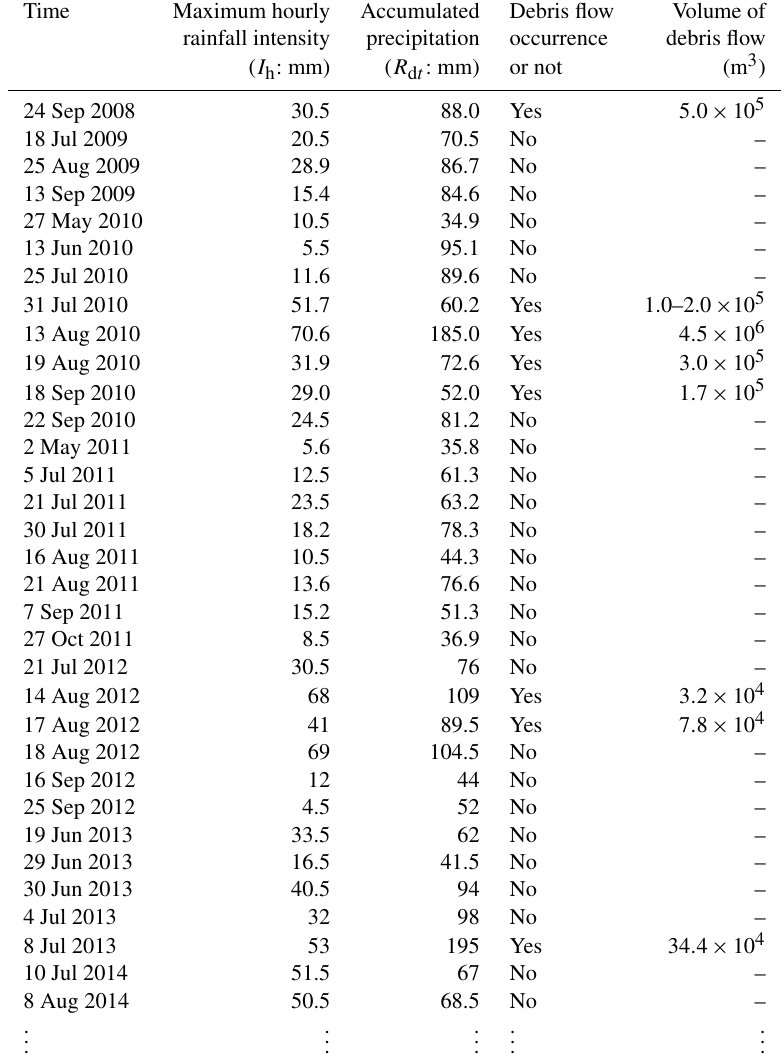
Table 1. Primary rainfall events in the catchment of Wenjia gully (2008–2018), added from Xu (2010) and Yu et al.